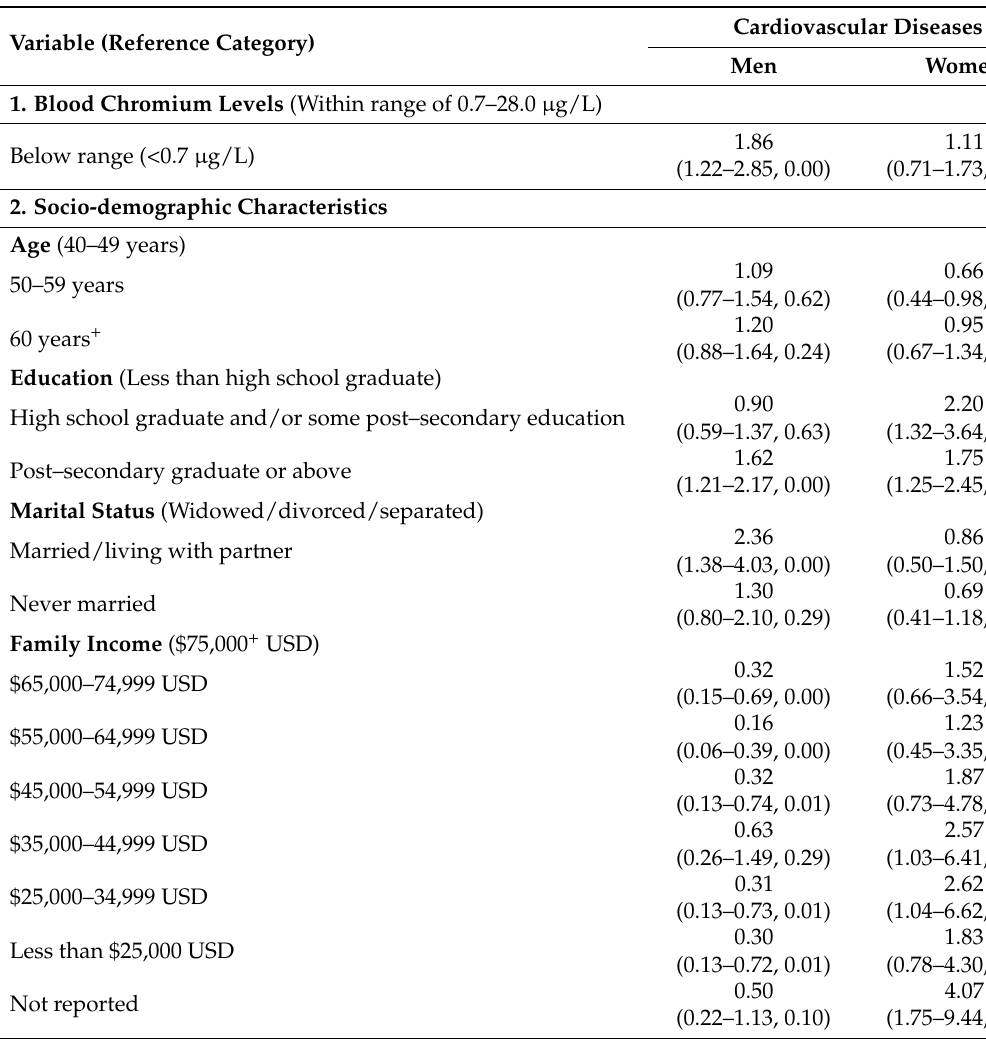
Table 1. Adjusted odds ratios (aOR with 95% confidence interval, p -value) of health conditions by demographic, social, economic, biological, and health